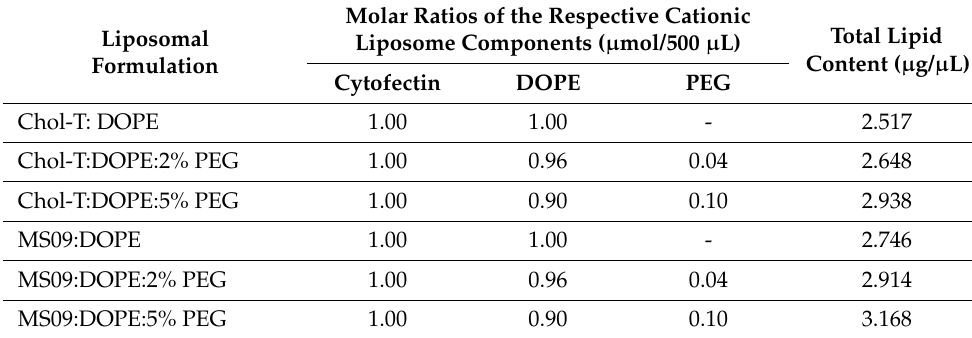
Table 1. Composition and molar ratios of the different cationic liposomal formulations.